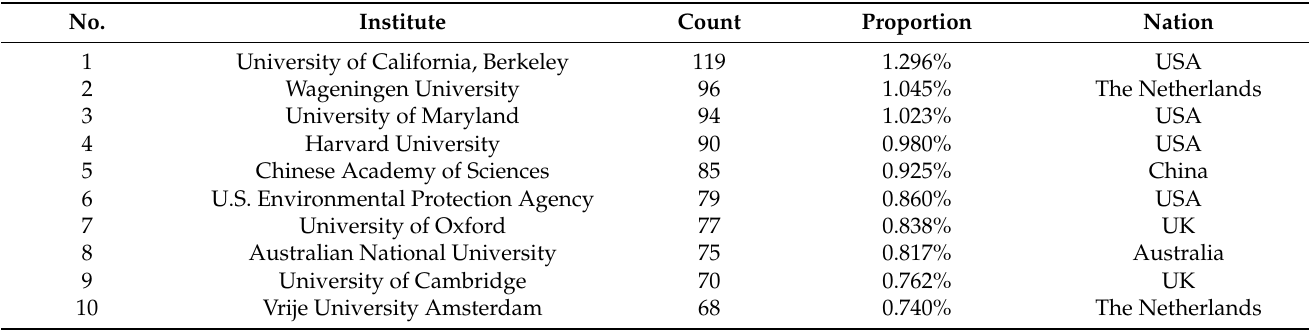
Table 3. Institutes with the highest contribution in research on environmental regulation from 2000 to 2019.